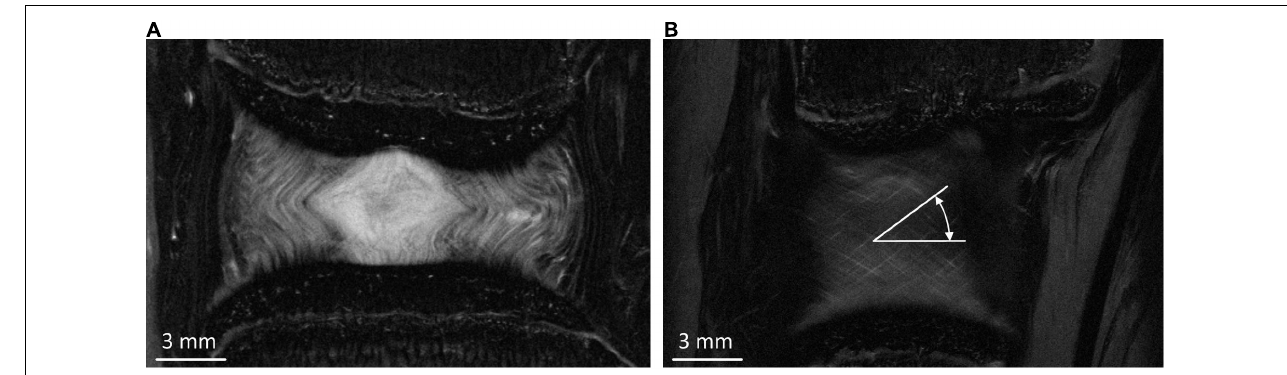
FIGURE 1 | (A) Middle coronal slice of the MRI of the bovine IVD. (B) Typical peripheral MRI slice from which fibre bundle angles were